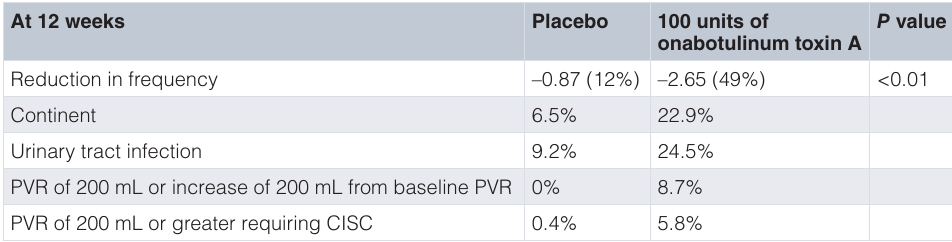
Table 1. Comparison of onabotulinum toxin A versus placebo in treating urge urinary